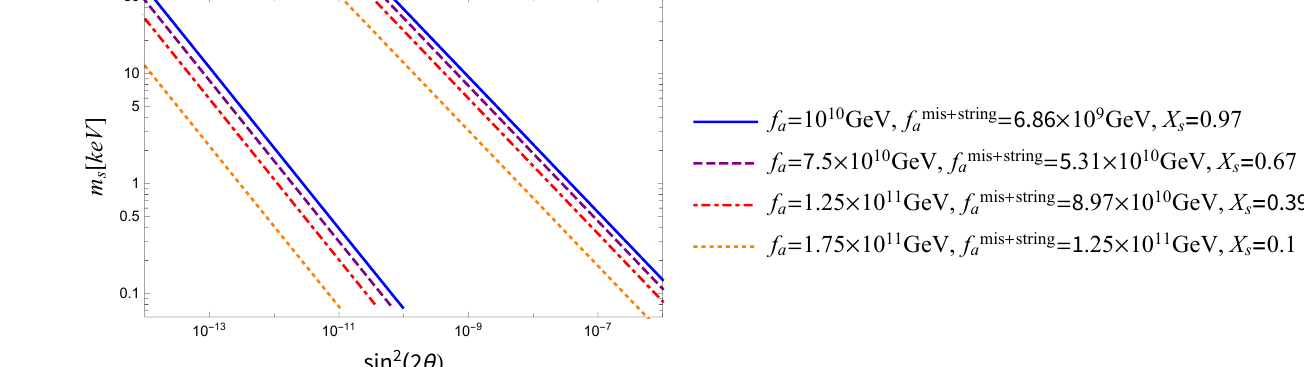
Figure 4. Sterile neutrino production range as the axion decay constant changes. For the first value of the axion decay constant, f a , we only take into account the misalignment mechanism for axion production. For the second value, f mis we take into account both the misalignment mechanism and the decay of topological defects setting λ A = 0.1. The upper line corresponds to the non-resonant production and the lower line is the BBN bound discussed in Section